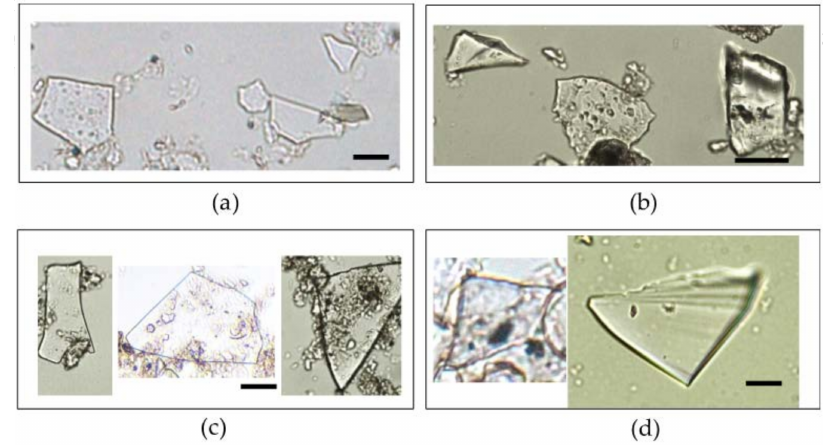
Figure 2. Microscopic observations of volcanic glass particles incorporated in ( a ) soil A, ( b ) soil B, ( c ) soil C, and ( d ) soil D. Each scale bar repesents 20 μm.